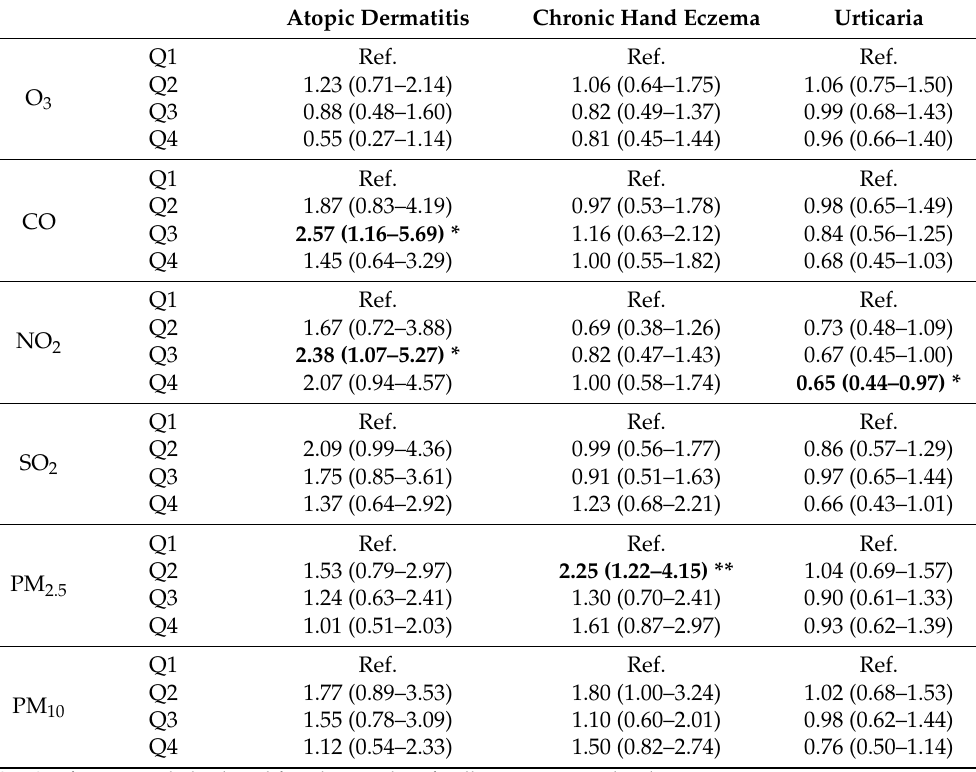
Table 4. Interactions between second-hand smoke (SHS) and air pollution exposure (OR (95% CI)). Atopic Dermatitis Chronic Hand Eczema Urticaria